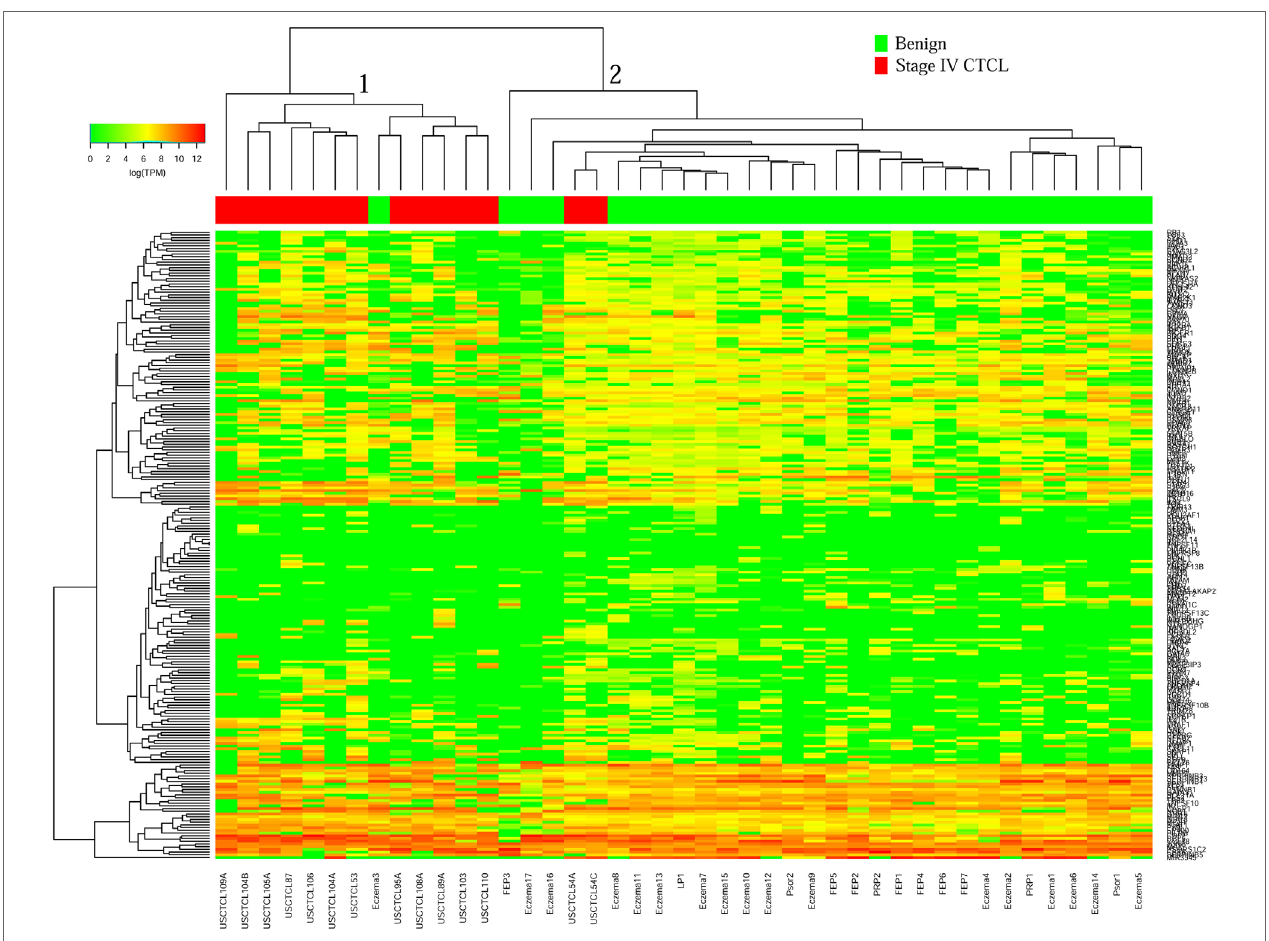
FigUre 3 | Unsupervised hierarchical clustering analysis based on TruSeq targeted RNA gene expression analysis of 284 select genes in benign inflammatory dermatoses (green) vs. ≤ 2008 stage IV formalin-fixed paraffin-embedded cutaneous T-cell lymphoma (CTCL) samples (red). A color key refers to gene expression in log(transcripts per